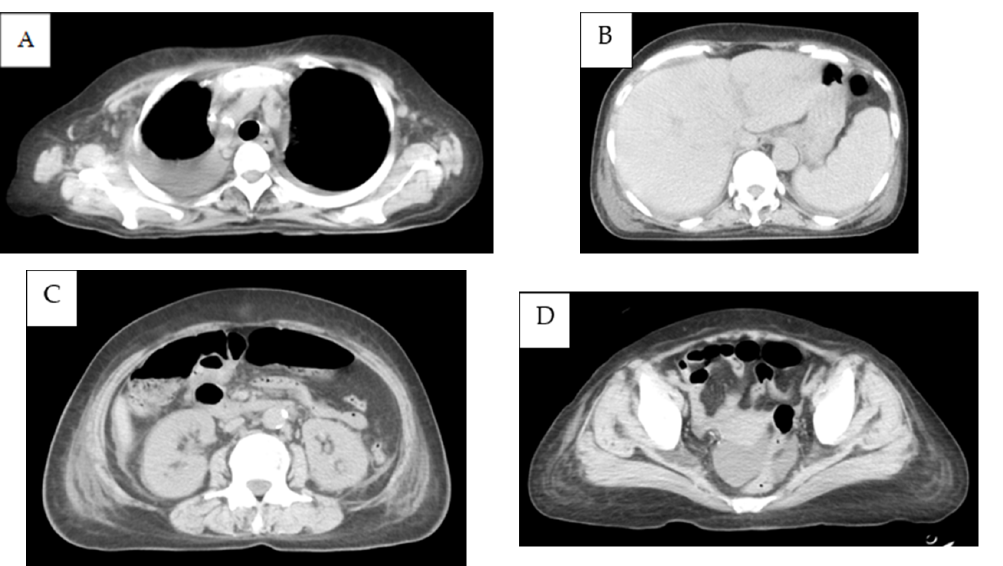
Figure 1. Contrast-enhanced chest and abdominal computed tomography recorded on day 6 of ad- mission. ( A ) Subtle axillary lymph node enlargement and pleural effusion; ( B ) exacerbated hepato- splenomegaly; ( C ) enlarged kidney and small para-aortic lymphadenopathy; ( D ) ascites effusion.